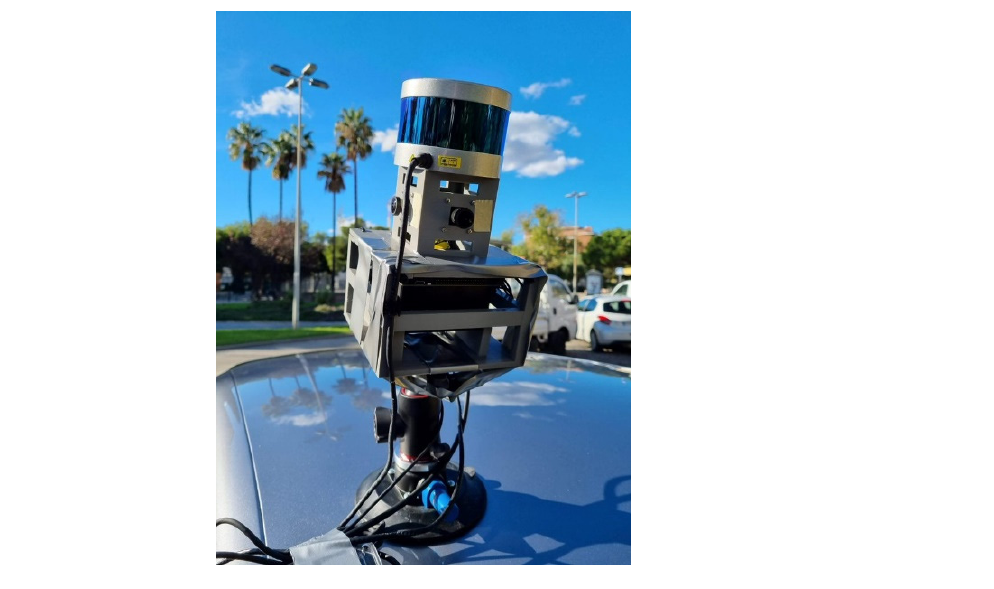
Figure 7. The mobile mapping system (MMS) mounted on top of a car.